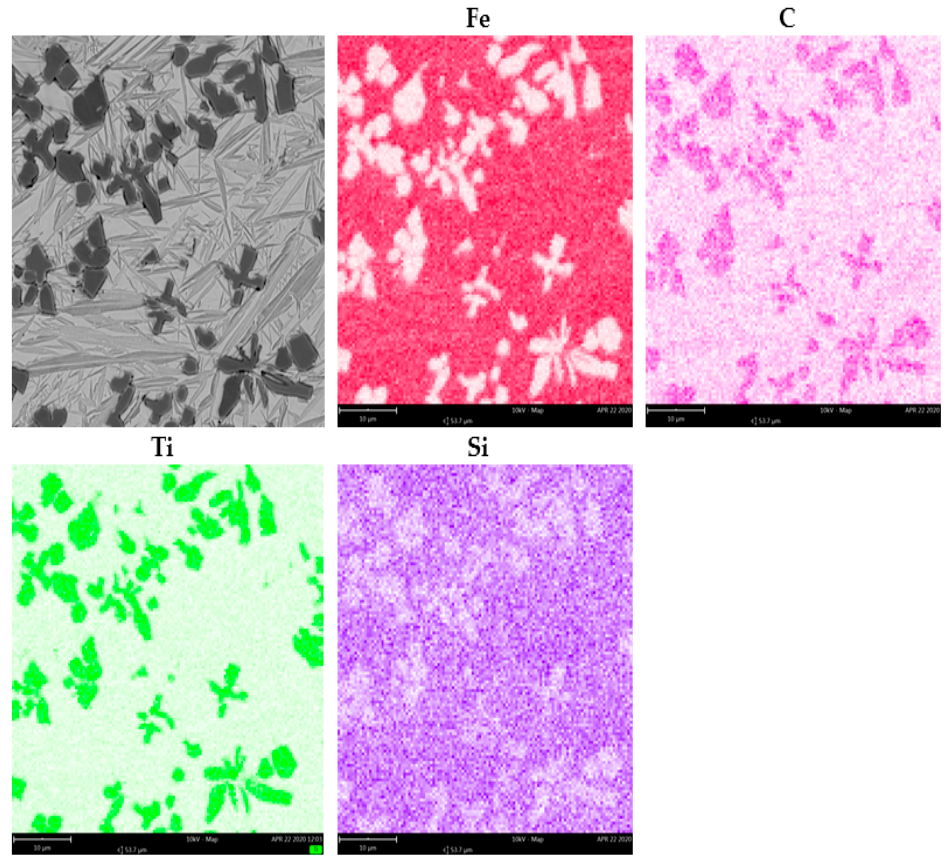
Figure 7. The energy dispersive spectroscopy (EDS) surface analysis result of the representative laser alloyed surface layer.